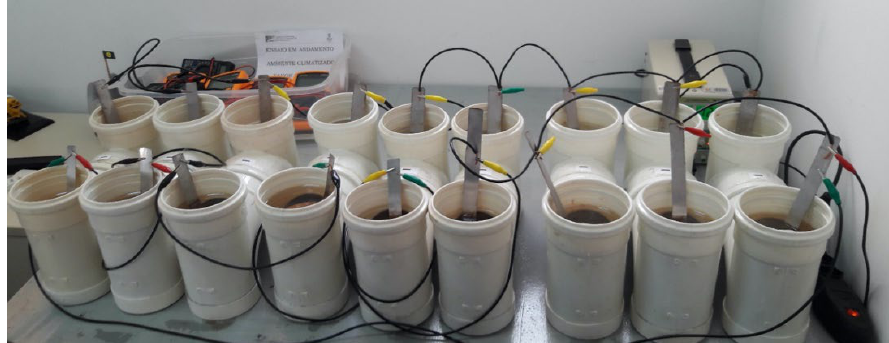
Figure 4. Execution of the multiregime test method.